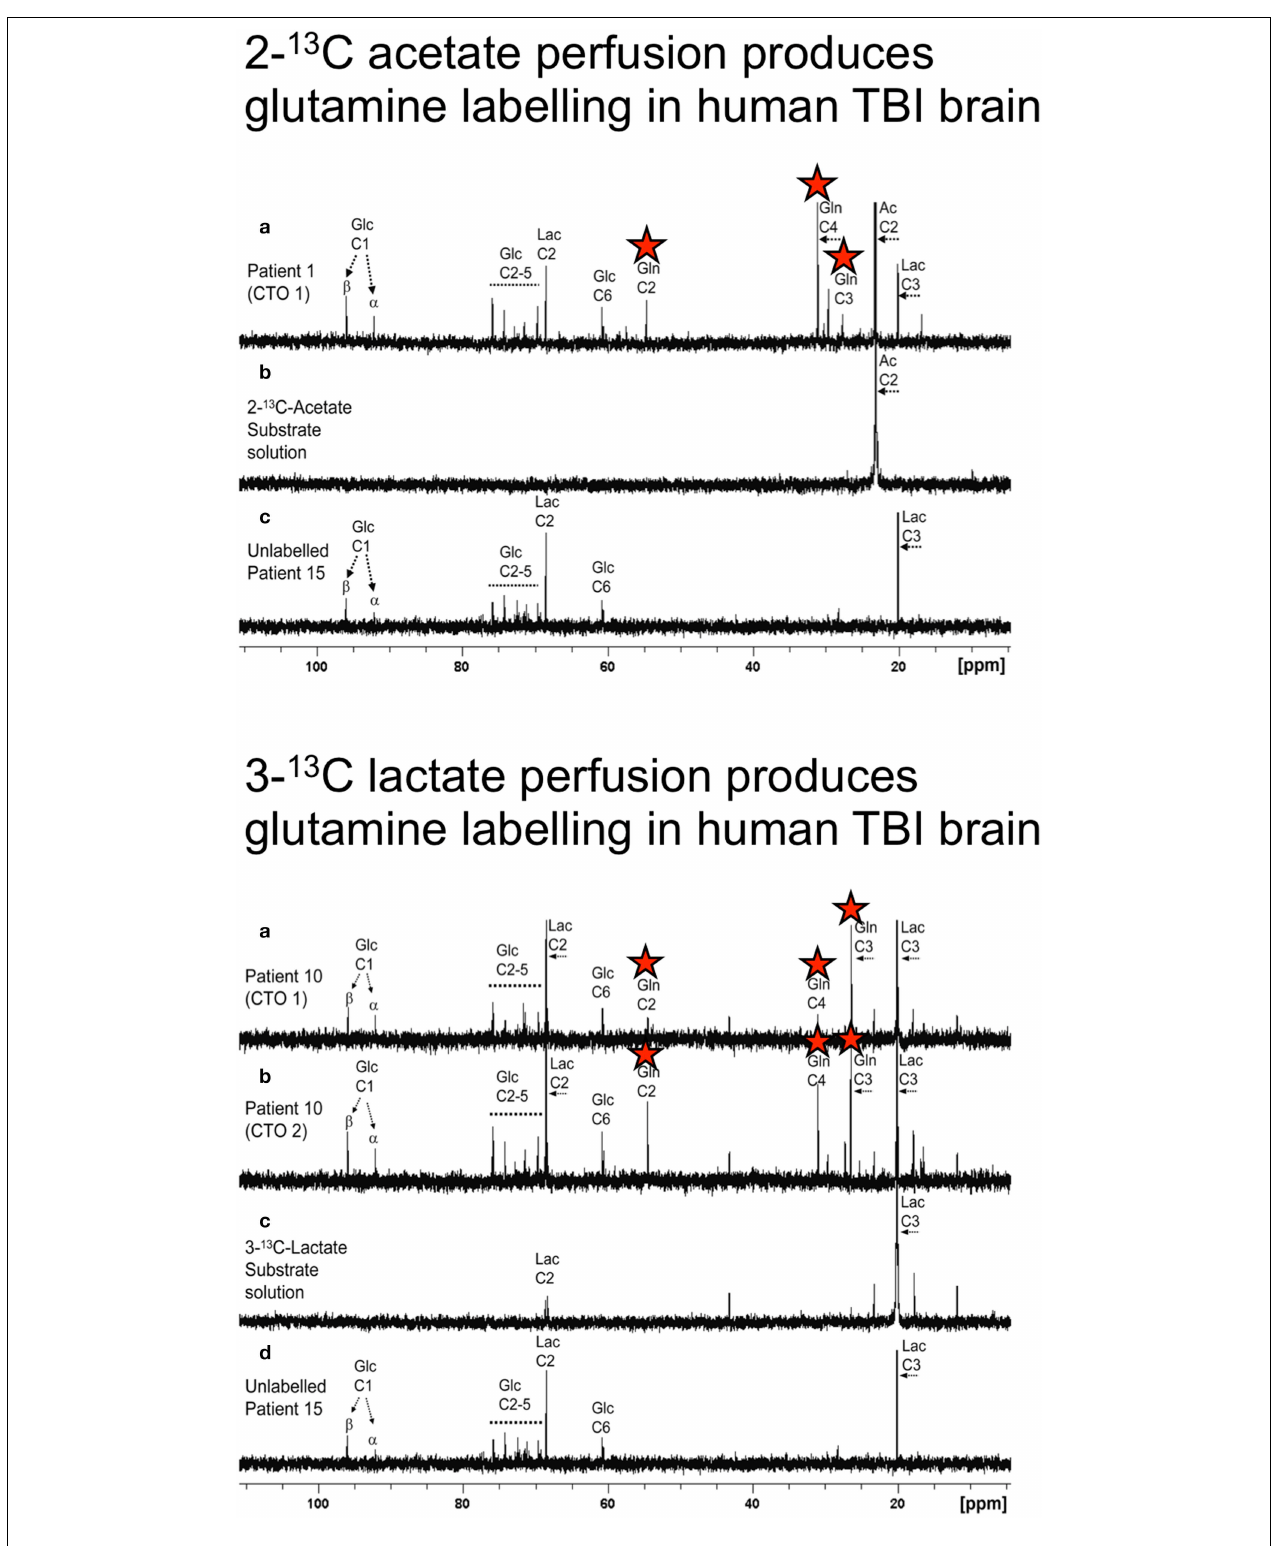
FIGURE 3 | Upper panel: (a) Example of 13 C NMR spectrum of brain microdialysate from a TBI patient, who received perfusion with 2- 13 C acetate (4mM) by a microdialysis catheter via a craniotomy (CTO); red stars indicate 13 C signals for glutamine C4, C3, and C2 indicating